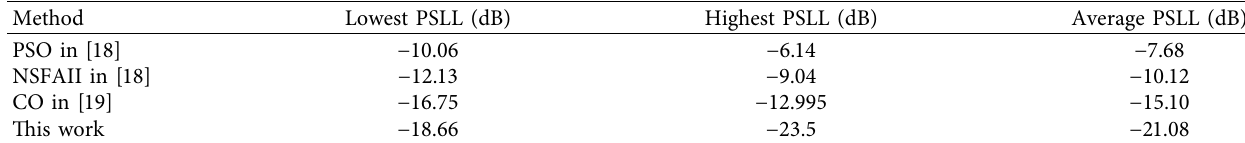
Table 1: Performance statistics of different algorithms in terms of